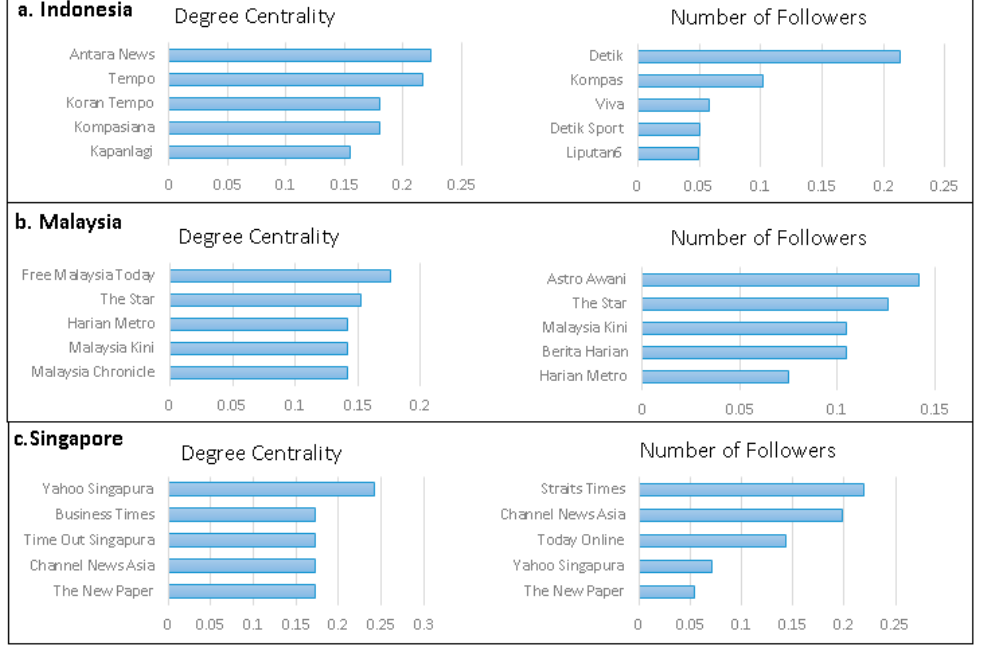
Figure 3. The top five online news media based on the degree value and the number of Twitter followers